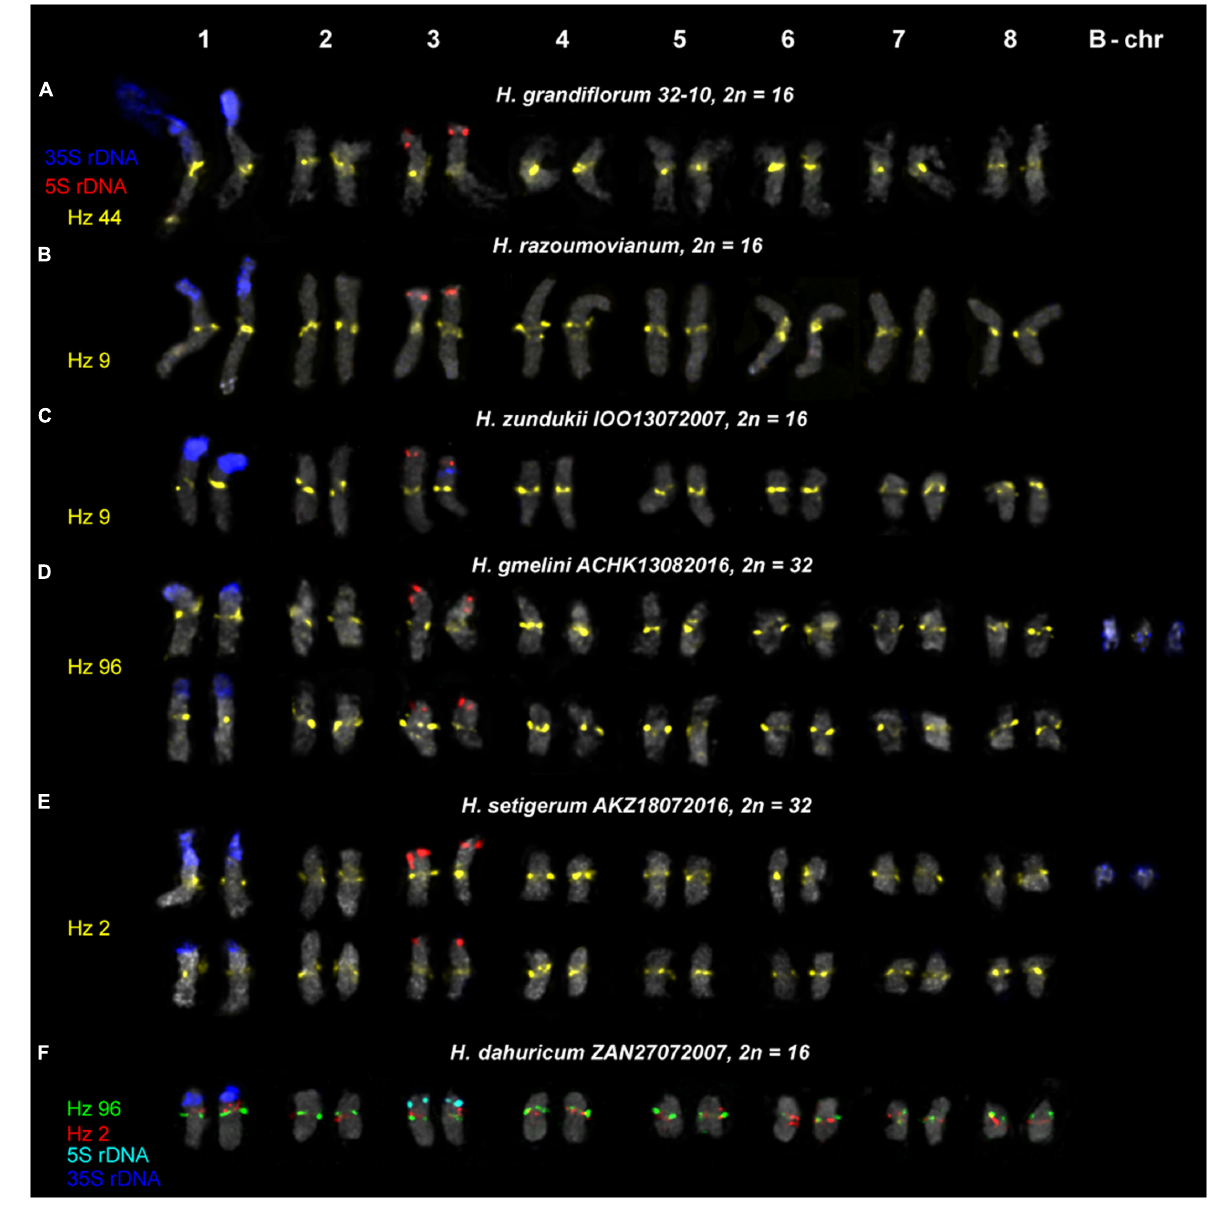
FIGURE 6 | Karyotypes of the studied accessions of H. grandiflorum (A) , H. razoumovianum (B) , H. zundukii (C) , H. gmelinii (D) , H. setigerum (E) , and H. dahuricum (F) after FISH with 5S rDNA, 35S rDNA and satellite repeats (the same metaphase plates as in Figures 3 , 4 ). The correspondent probes and their pseudocolors are specified on the